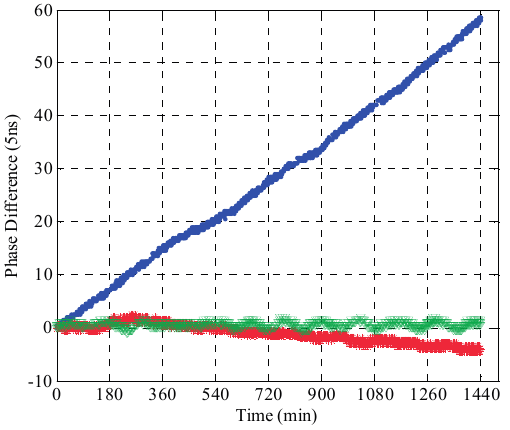
Figure 8. Experimental results of GNSS disciplined rubidium clock